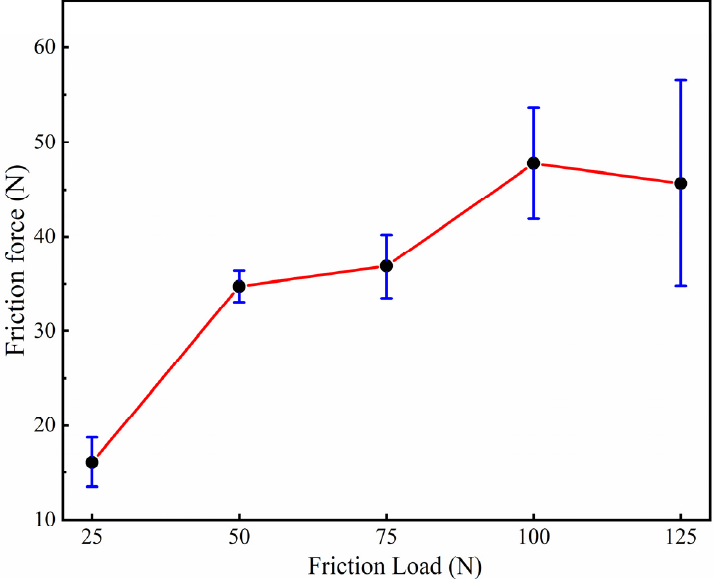
Figure 12. The curve of the mean frictional force and frictional load of sample YG8-20 (the points represent the frictional forces of the sample YG8-20 under different loads; the error value of the frictional force is shown in green; red indicates the shift curve between the load and frictional forces).